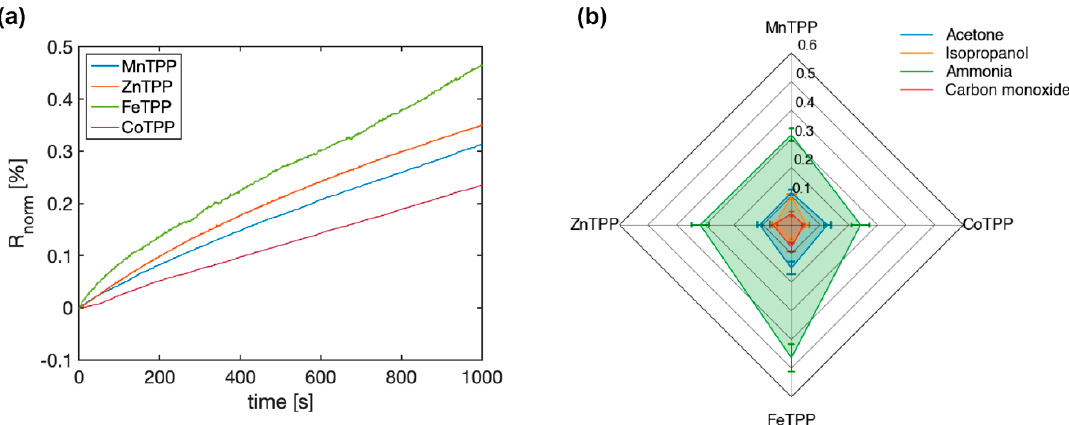
Figure 4. The SEM images describe the morphology of ( a ) a GO film and ( b ) an RGO film. The EDS spectra of ( c ) a GO film and ( d ) an RGO film are shown.